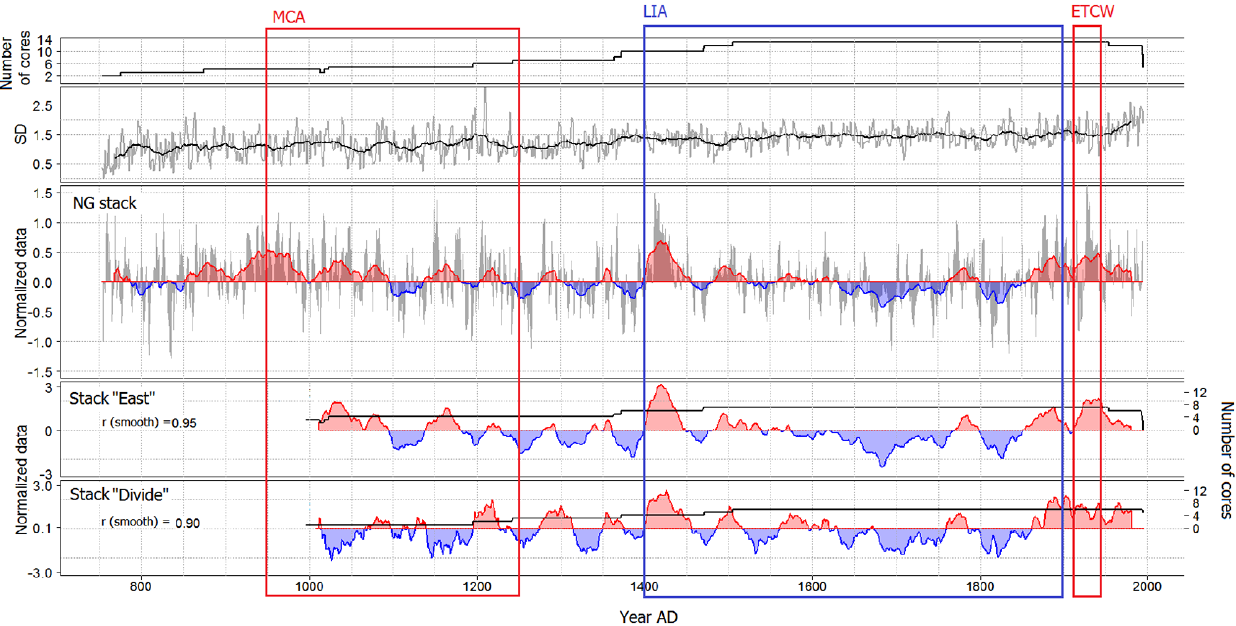
Figure 5. Top two panels: the number of cores used for the stack and the standard deviation (SD; gray: annual values; black: 30-year running mean) of all times. Middle: annual stacked δ 18 O (gray) and smoothed record (30-year running mean). Values more enriched compared to the mean (AD1953–1505) are shown in red, while values less enriched are shown in blue. Known climate anomalies are marked: Medieval Climate Anomaly (MCA, AD950–1250; Mann et al., 2009), the Little Ice Age (LIA, AD1400–1900; Mann et al., 1998), and early twentieth century warming (ETCW, 1920–1940; Semenov and Latif, 2012; Wood and Overland, 2010). Bottom two panels: 30-year running mean on z levels (centered and normalized data) of stacked northern Greenland δ 18 O records over the last 1000 years. Stack “East”: B16, B17, B18, B19, B20, B21 and B23. Stack “Divide”: B22, B26, B27, B29, B30 and NGRIP. Values in red are more enriched compared to the mean over their last 1000 years, and those in blue are less enriched. Also given is the correlation coefficient of 30-year running means between the NG stack and the sub-stacks (AD1505–1993). The coefficient for a similar correlation between the two sub-stacks is calculated with r =